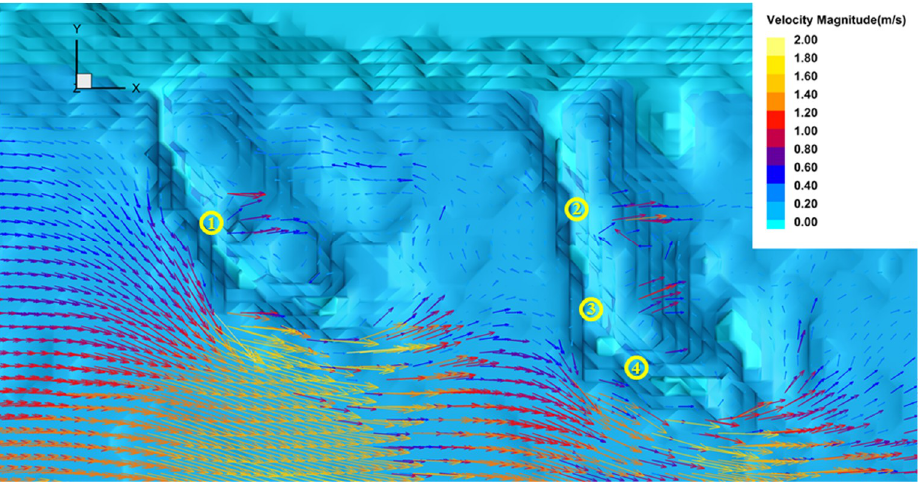
Figure 11. Potential damage positions around the double spur dikes in shallow submerged condition (top view with 3D flow field).